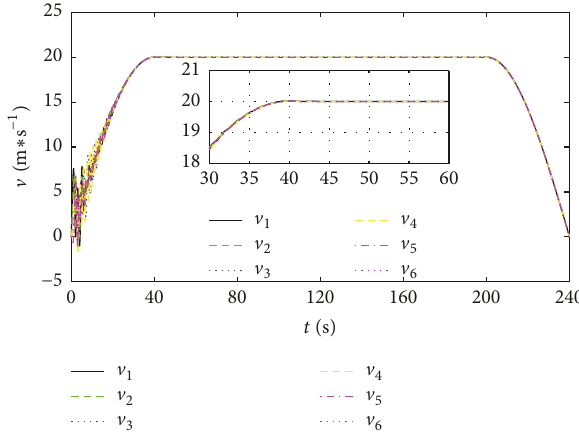
Figure 3: Positions of each vehicle and position gaps between vehicles.